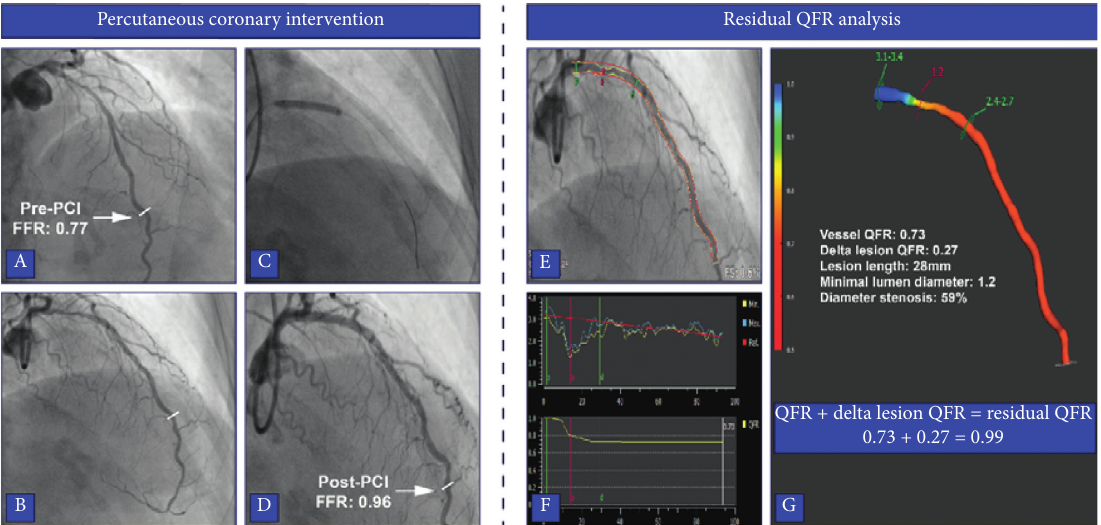
Figure 1: Case example of residual QFR analysis. (a-b) Two end-diastolic frames of ICA in a patient with a proximal LAD lesion (FFR: 0.77). The stenosis was angiographically and functionally (post-PCI FFR: 0.96) successfully revascularized (c-d). During the QFR analysis, vessel contours were automatically detected on the two end-diastolic frames and manually corrected if needed (e). A 3D model of the coronary was reconstructed based on the vessels contours and lesions are presented as a drop in vessel diameter and QFR (g-f). The proximal and distal markers of the lesion in the QFR analysis were matched with the treated location during PCI to allow virtual removal of the lesion (c, f-g). Residual QFR was calculated by adding the delta QFR of the lesion to the vessel QFR (g). FFR: fractional flow reserve, ICA: invasive coronary angiography, LAD: left anterior descending artery, PCI: percutaneous coronary intervention, and QFR: quantitative flow